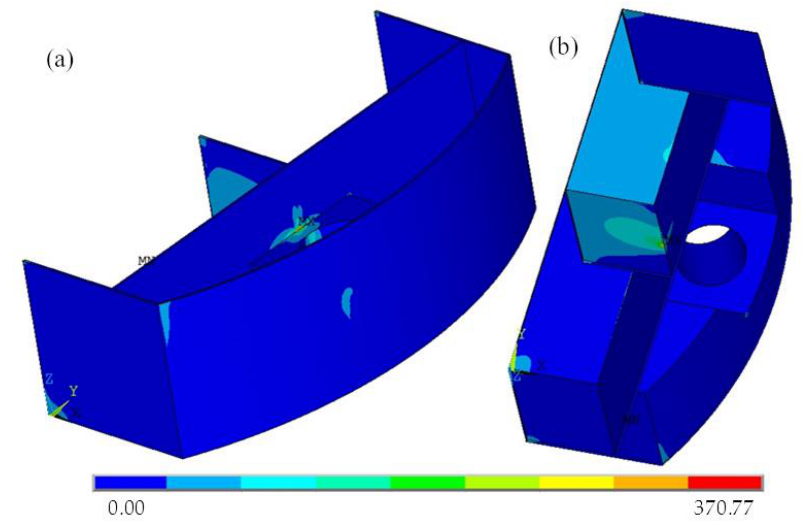
Figure 12. Distribution of the von Mises stress (in MPa) for the rectangular / elliptical shape of the superior bracket under ULS conditions: ( a ) superior view and ( b ) inferior view.